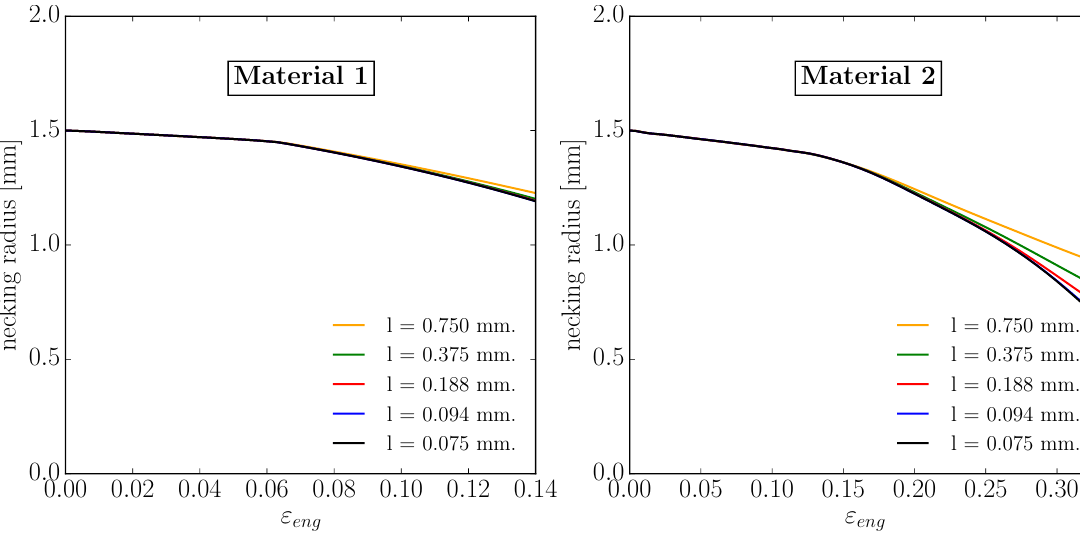
Figure 21. Necking radius evolution for Material 1 ( left ) and Material 2 ( right ); comparison of meshes with different element sizes in the longitudinal direction at the necking